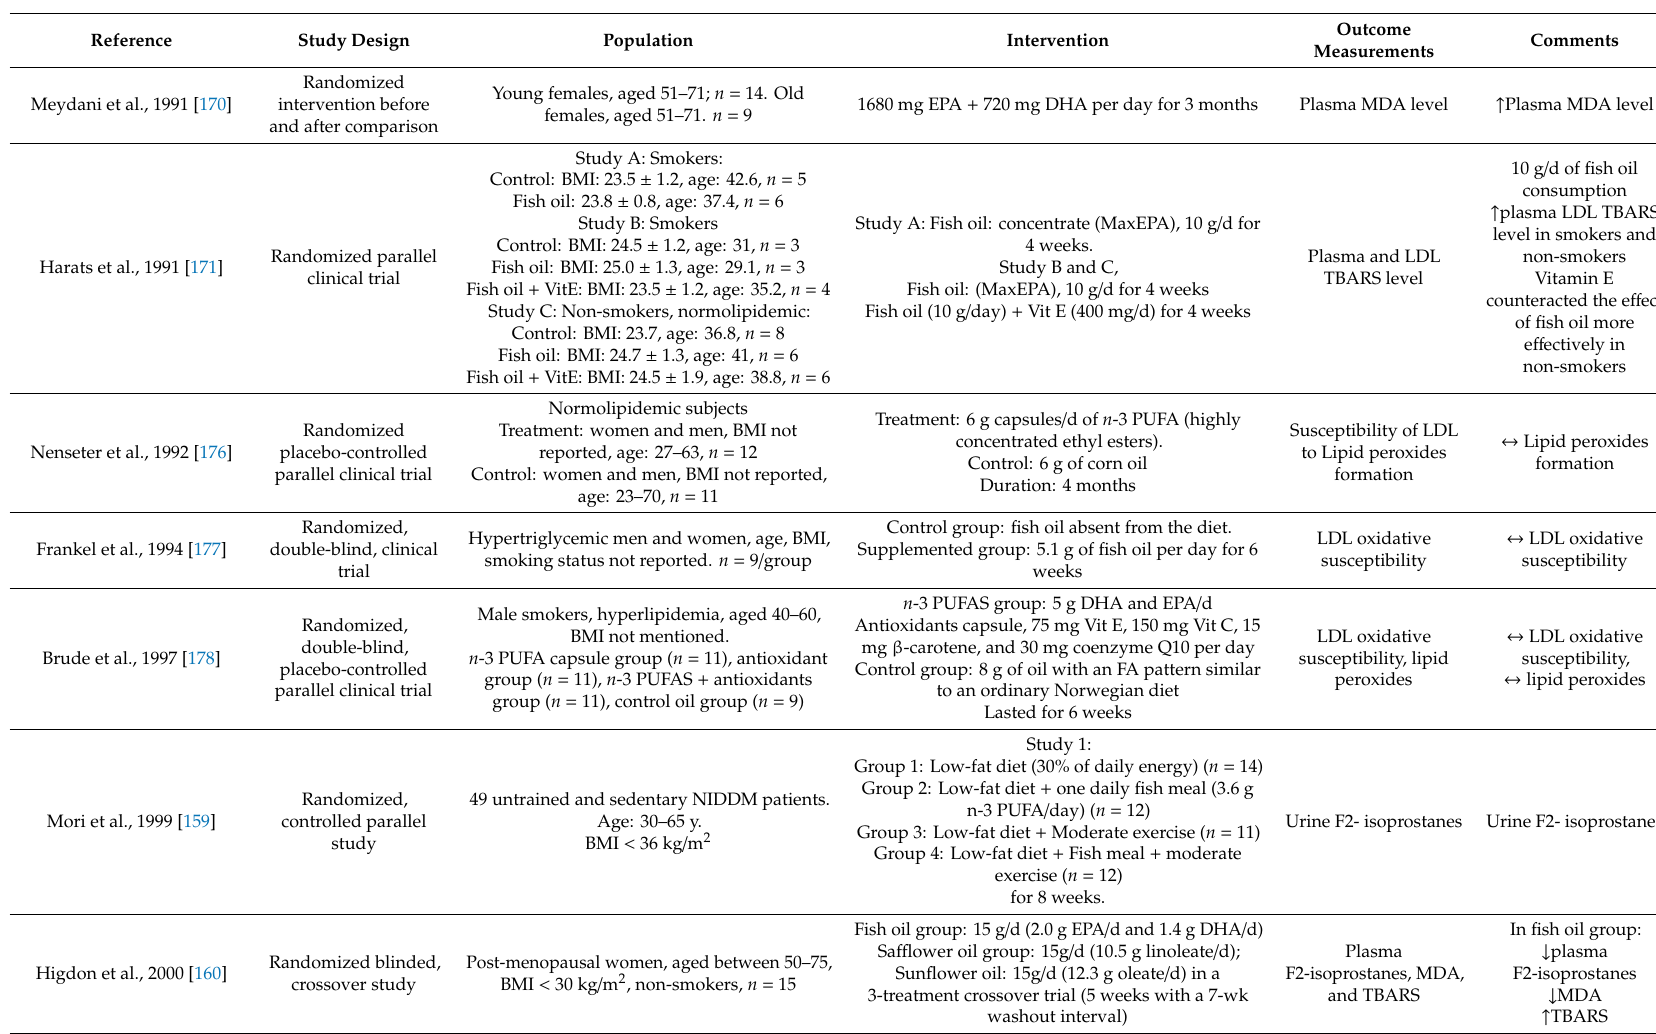
Table 2. E ff ects of n-3 PUFA supplementation in oxidative stress in healthy subjects or in population with cardiometabolic